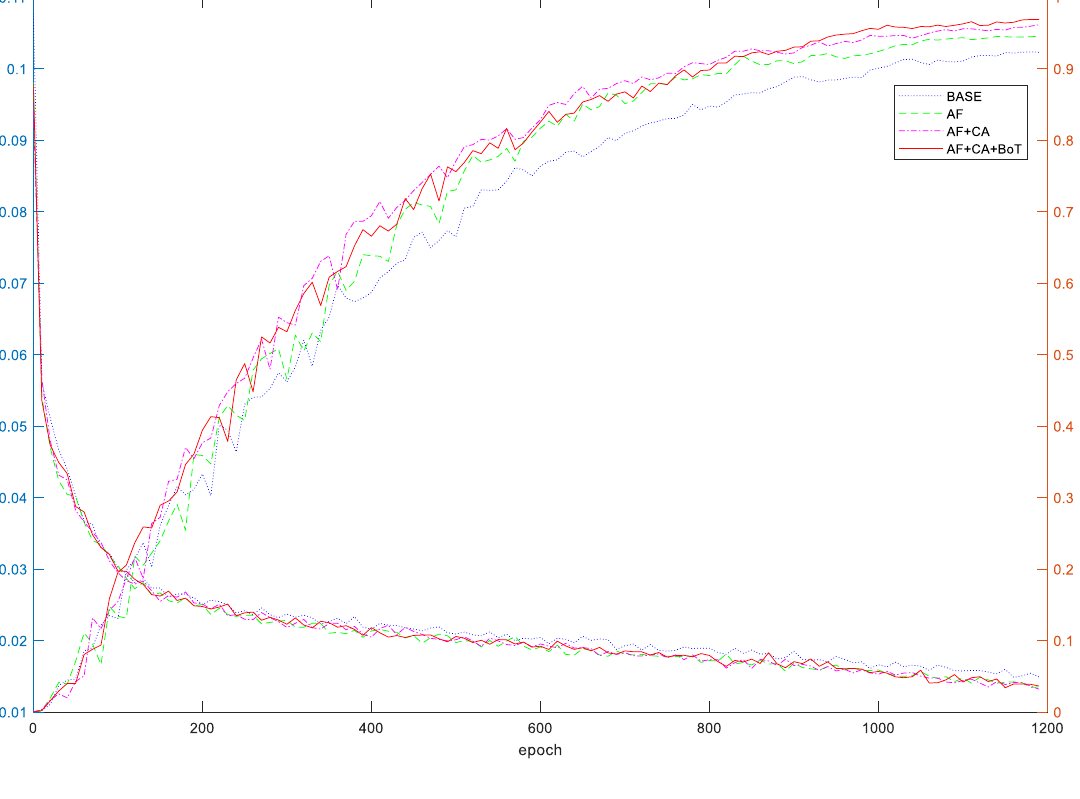
Figure 8. Results of the ablation experiment.